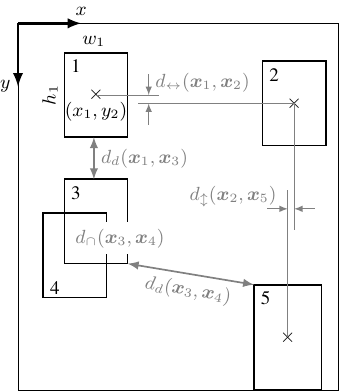
Figure 1: Properties of neighbouring objects. Therefor, we reduce all rectangles to their center points and eval- uate the according adjacency graph. Objects, neighboured within the adjacency graph, are said to be neighbours in image space. The reason, not to use the exoskeleton of the objects themselves is, that at high temperature of simulated annealing the objects might overlap, thus, get merged to one component for processing the